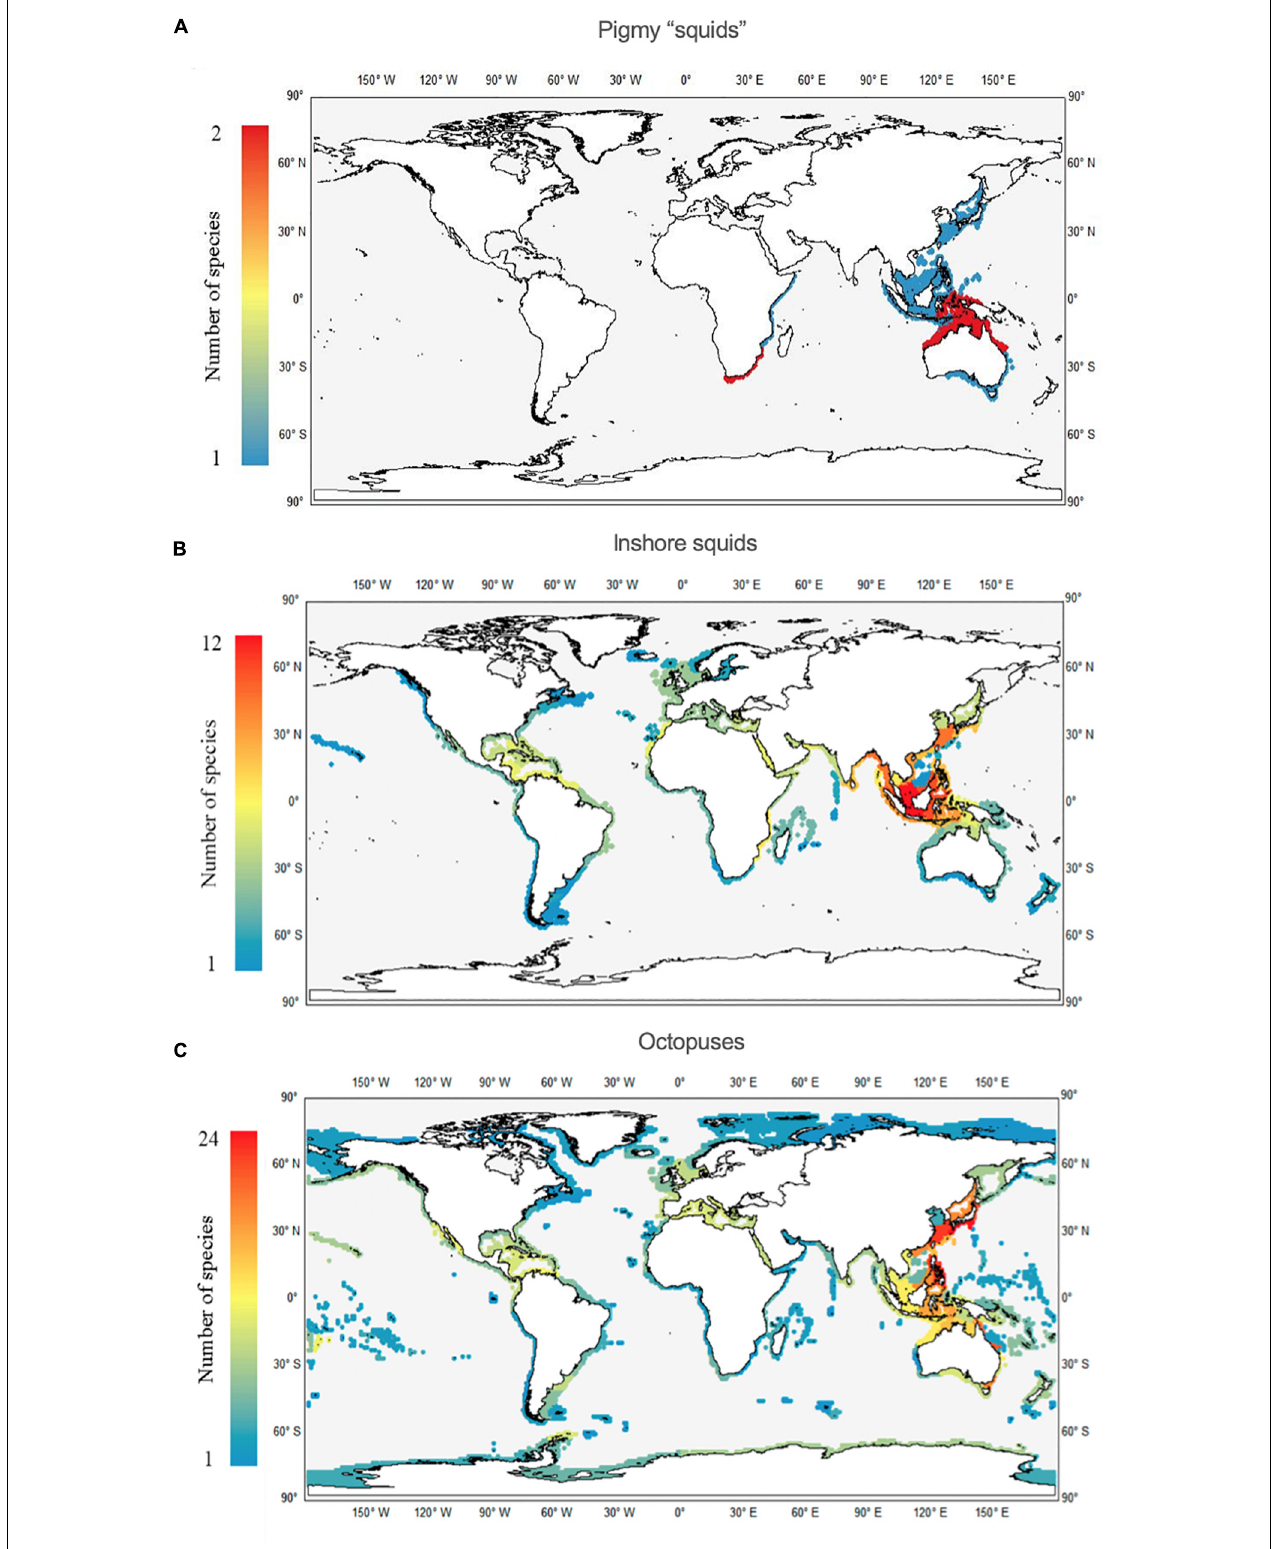
FIGURE 6 | Worldwide richness (number of species per ecoregion) patterns of pygmy squids (Family Idiosepiidae; A ), inshore squids (Family Loliginidae; B ) and octopuses (Families Octopodidae, Eledonidae, Enteroctopodidae, Megaleledonidae, and Bathypolypodidae; C ).